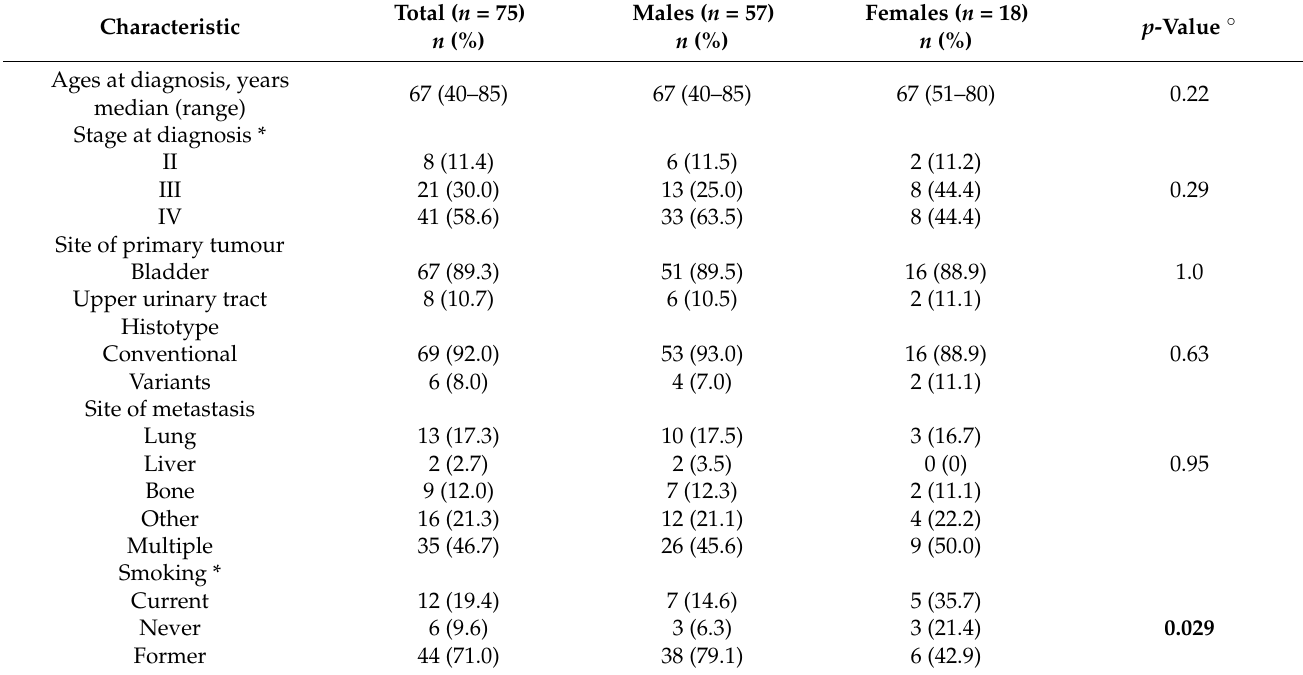
Table 1. Characteristics of 75 patients treated with chemotherapy between 2013 and